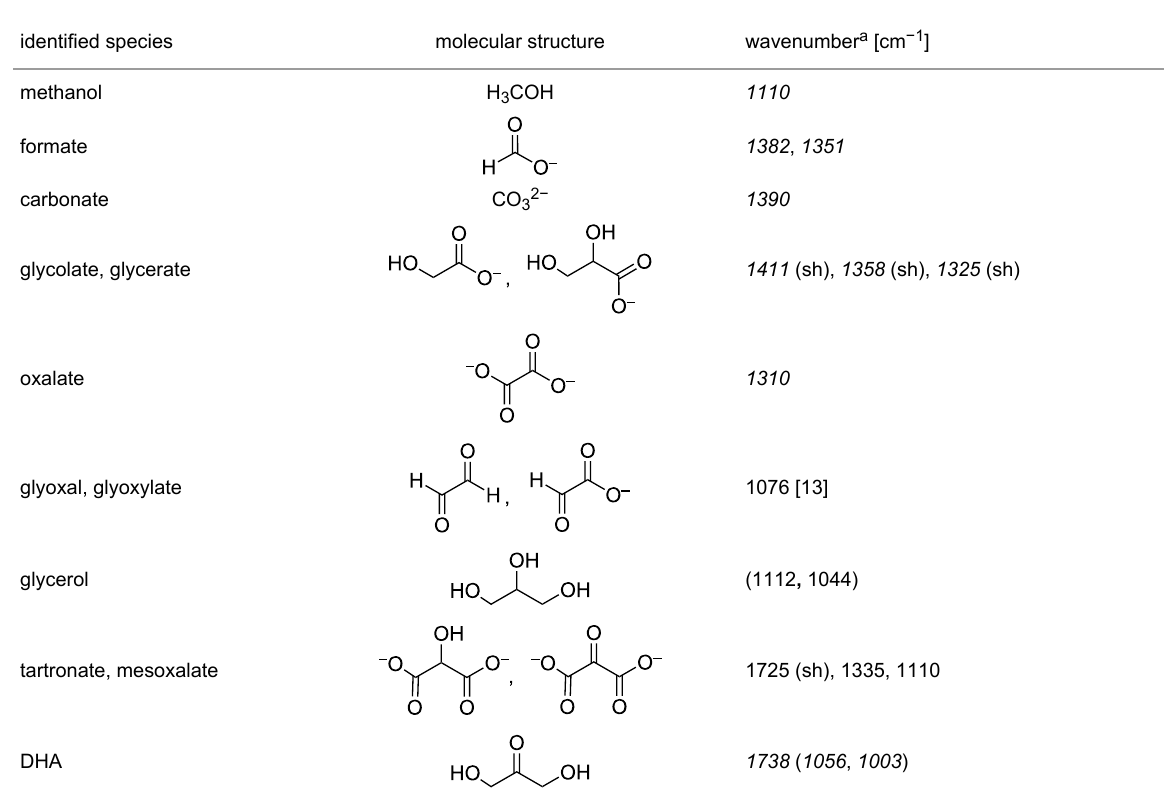
Table 2: Wavenumbers of identified species found in the IR spectra. Wavenumbers in italics originate from homemade reference experiments, other species were identified using refs. [15,16] if not indicated differently.